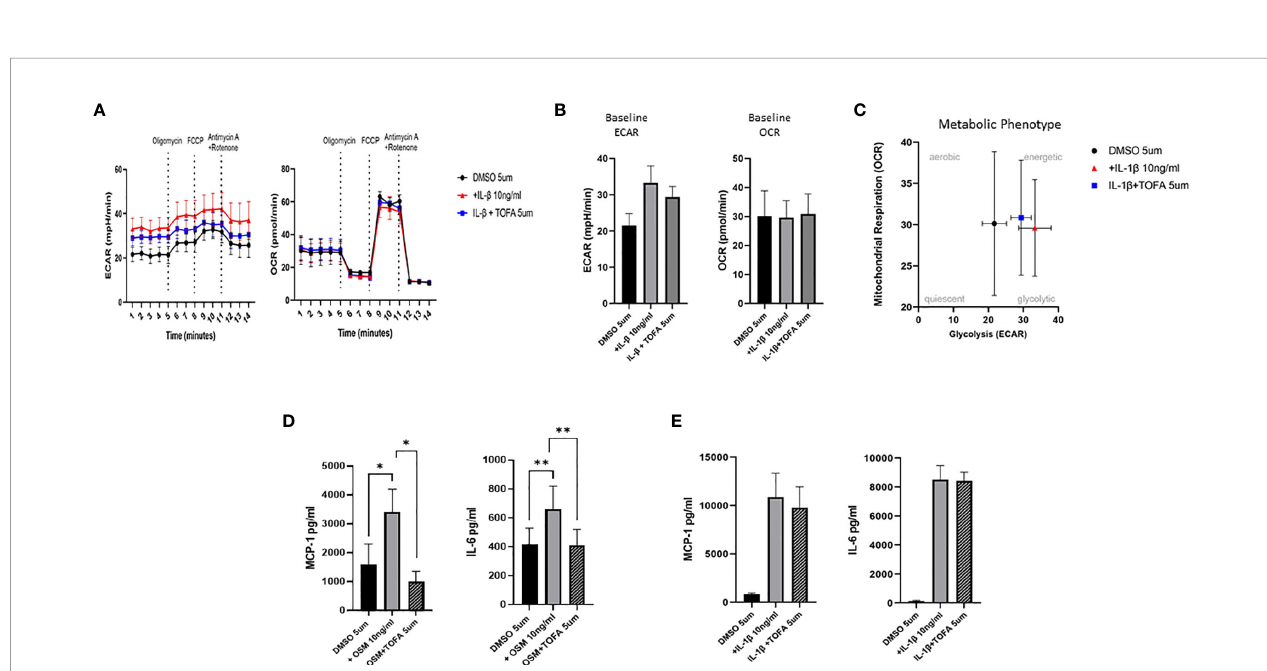
FIGURE 4 | Effect of Tofacitinib on the IL-1B or OSM induced expression of pro-in fl ammatory mediators and bioenergetic pro fi le in PsAFLS. (A) Average seahorse pro fi les demonstrating extracellular acidi fi cation rate (ECAR) (glycolysis) and oxygen consumption rate (OCR) (oxidative phosphorylation). (B) Representative bar graphs demonstrating baseline ECAR and OCR. (C) Metabolic phenotype pro fi le of PsAFLS, n=3. (D, E) PsAFLS were treated with Tofacitinib (5 µM) or DMSO (5 µM) for 1 h and stimulated with OSM (10ng/ml) (n=7) or IL-1 b (10 ng/ml) (n=3) for 24 h. and MCP-1 and IL-6 quanti fi ed. Values expressed as mean +/- SEM * p <0.05, ** p <0.01.